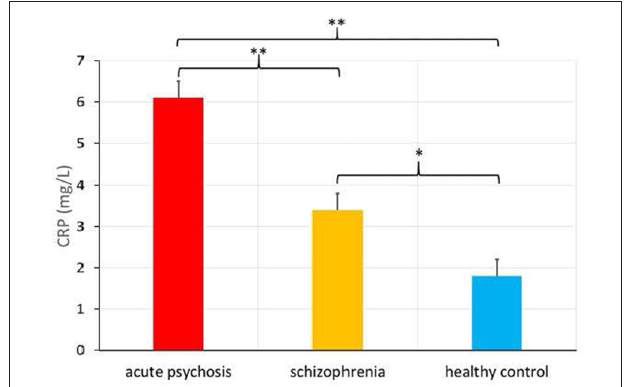
FIGURE 1 | C-Reactive Protein (CRP) levels (in mg/L) in patients admitted for an acute psychotic episode, chronically ill patients with schizophrenia, and healthy controls (means provided with standard error), * p < 0.01, ** p <